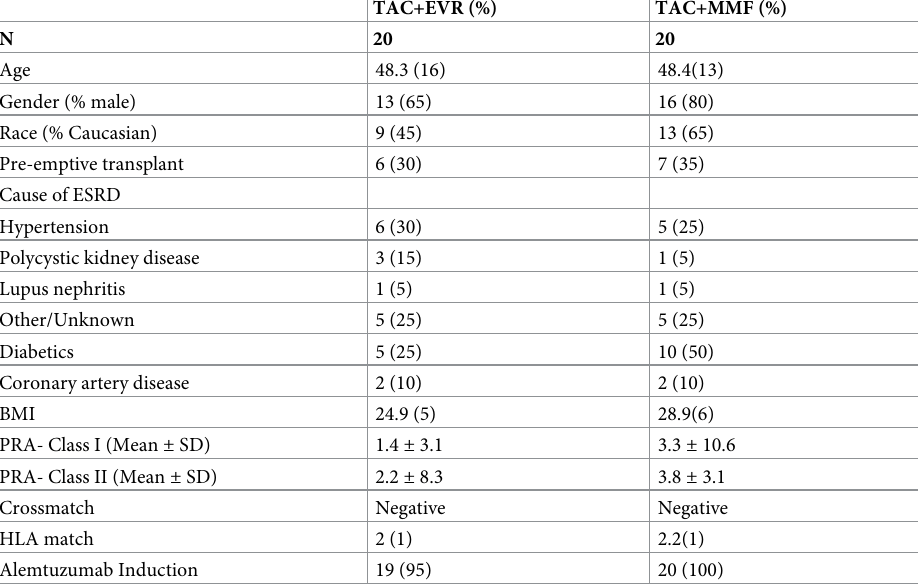
Table 1. Baseline